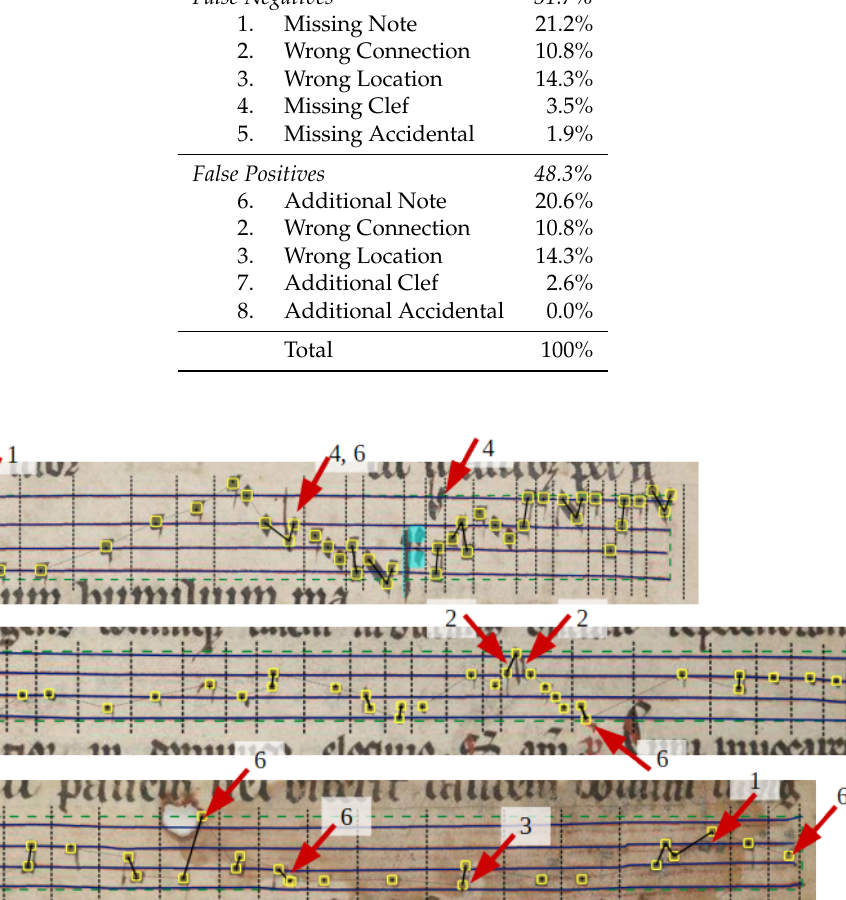
Figure 14. The three lines exemplarily show typical errors of the symbol detection algorithm. Refer to Table 9 for the definition of the numbers indicating different groups. The yellow boxes mark single NCs, solid lines between two NCs indicate that the second note is graphically connected to the previous. The dashed vertical lines separate single neumes and therefore represent logical connections. The cyan symbols denote clefs. The connecting thin dotted line represents the reading order of the